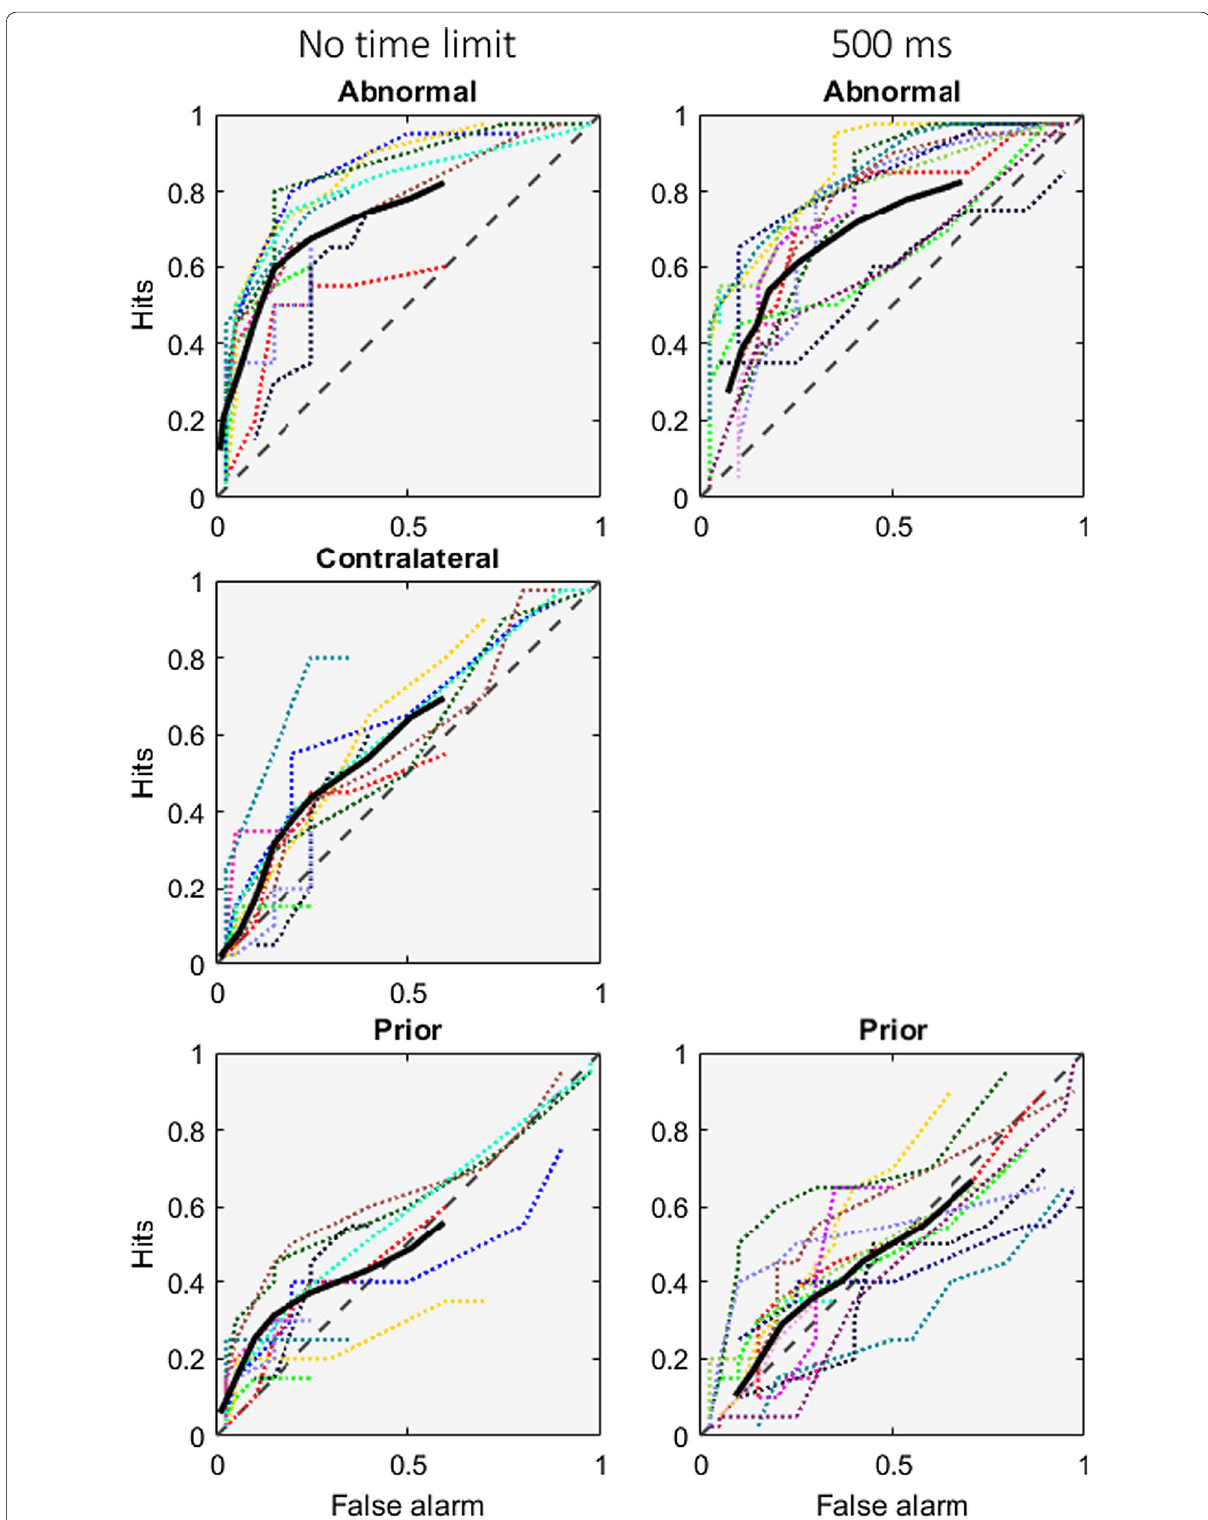
Fig. 3 ROC curves for the radiologist groups during no time limit and 500-ms time limit conditions per image type (subtle abnormal, contralateral, priors). Each plot contains individual ROCs (coloured dotted lines) and the group mean ROC (thick black line). The dashed grey diagonal line indicates the line of no